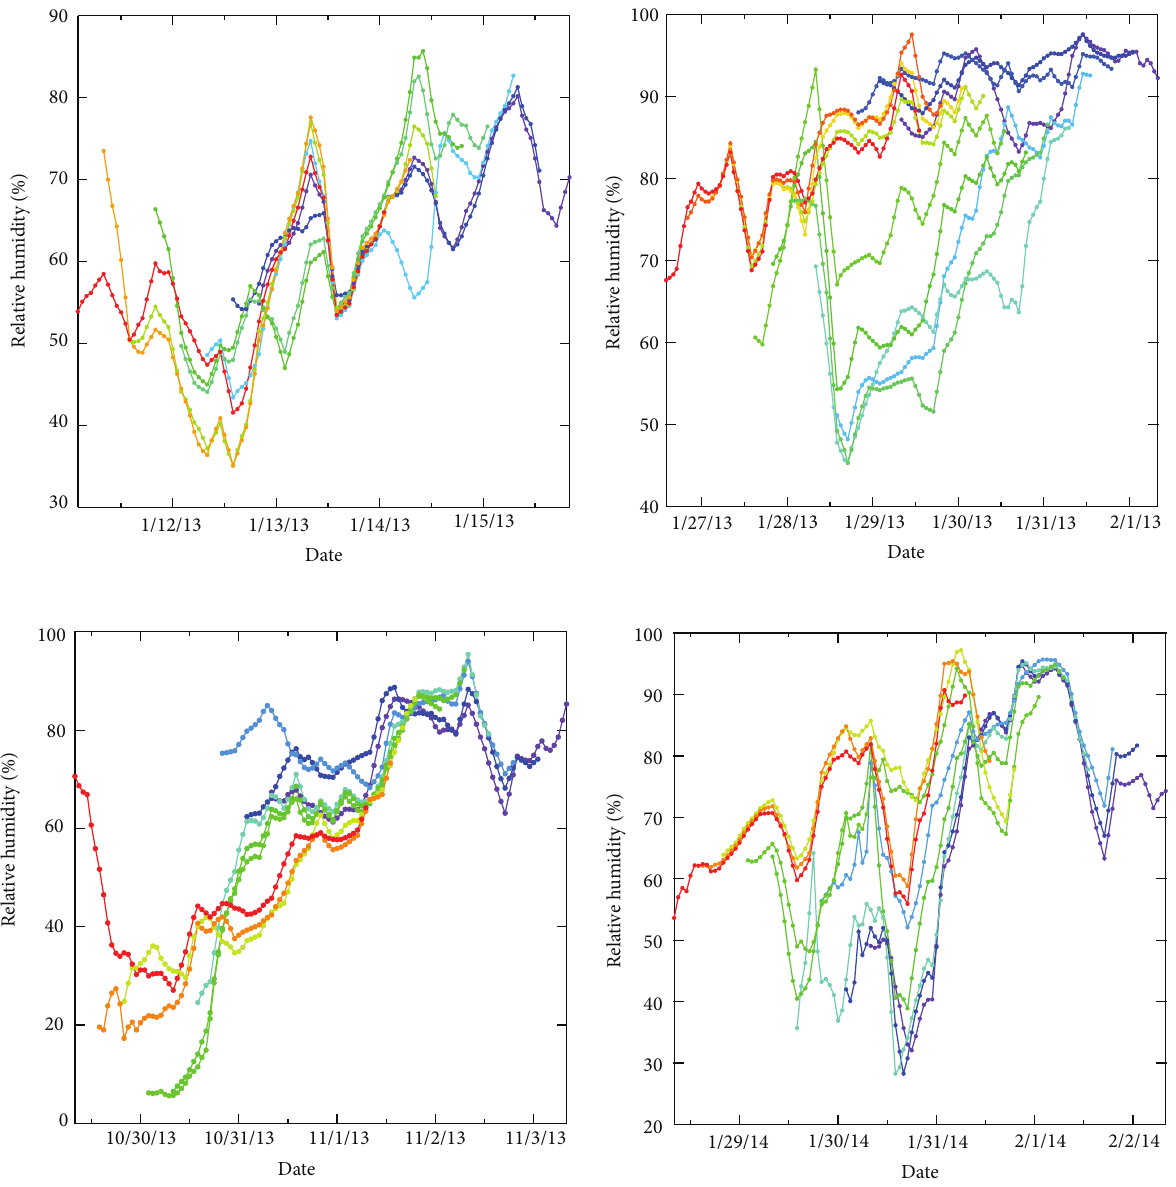
Figure 4: Changes in relative humidity along the air-mass back trajectories for the four fog events occurring in Ji’nan during the period from March 2012 to February